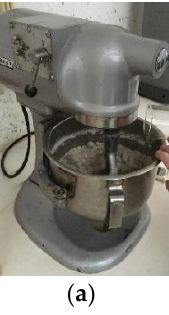
Figure 2. Manufacture of specimens: ( a ) Hobart N50 mixer; ( b ) fresh mortar in the mixer container; ( c ) steel plate with thermocouples applied; ( d ) specimen in the process of curing during the first 48 h.